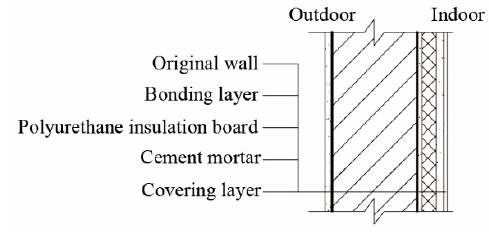
Figure 30. Internal thermal insulation.